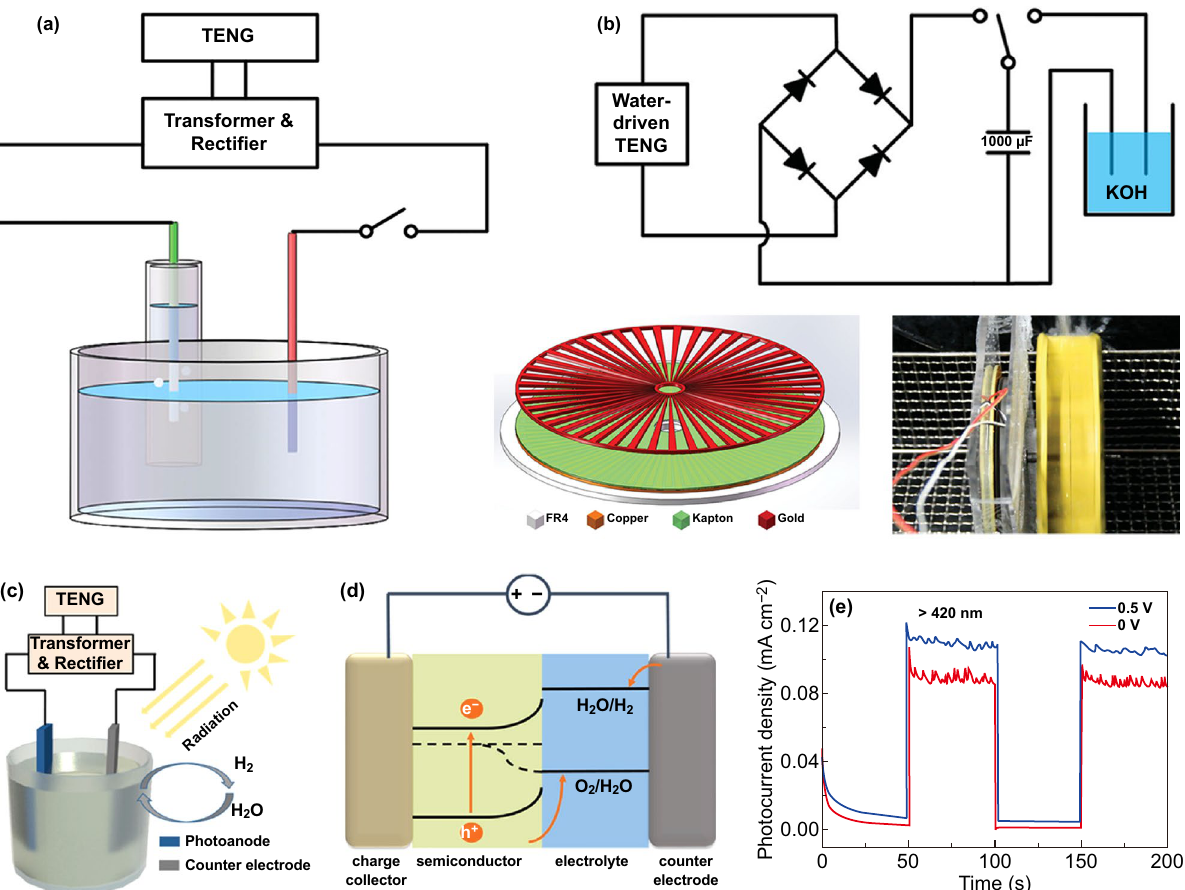
Fig. 13 a Schematic diagram of the TENG-driven water splitting system, b the circuit diagram of the splitting system and the structure of disk TENG. Reproduced with permission from Ref. [172]. Copyright 2014 John Wiley and Sons, c schematic diagram of the TENG-PEC hybrid cells, d illustration of simplified energy diagram for n-type semiconductor-based solar water splitting, e photocurrent of as-prepared Au-deco- rated TiO 2 with different bias. Reproduced with permission from Ref. [173]. Copyright 2017 John Wiley and